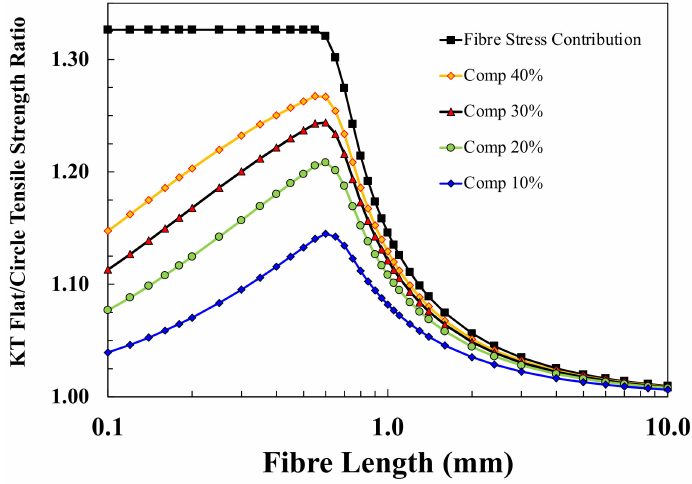
Figure 7. Kelly–Tyson equation prediction of flat/circle strength ratio for GF-PP including matrix contribution and average fibre orientation for injection moulded samples.